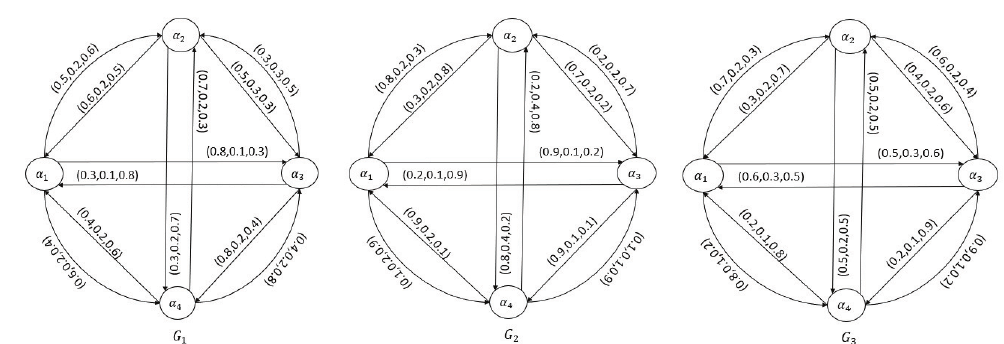
Figure 2. T -spherical fuzzy directed